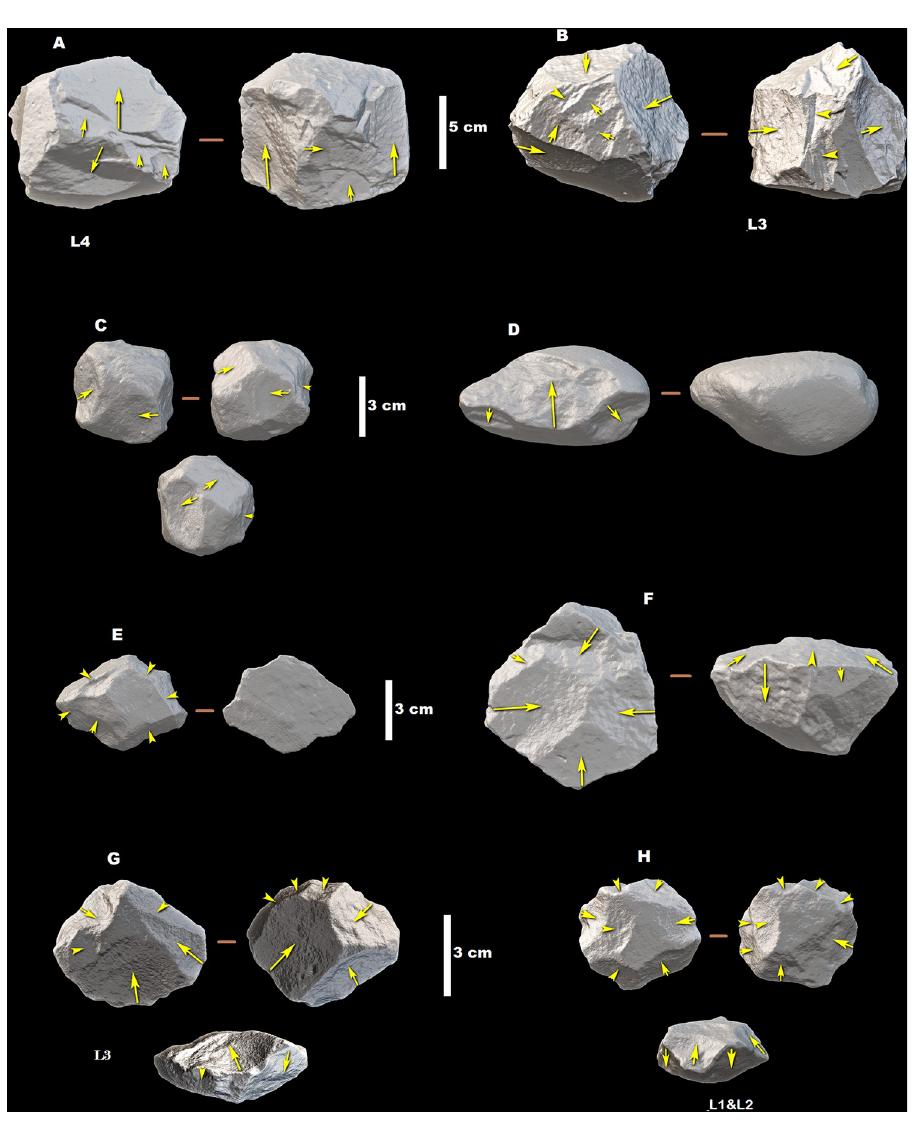
Fig 6. Cores from the small to medium-sized flaking system from MW2-L4 (A), MW2-L3 (B–G), and MW2-L1&L2 (H); (A), (B), and (C) are Multifacial cores; (D) Bifacial abrupt partial (BAP) exploited core; (E) Core on flake; (F) Bifacial hierarchical centripetal (BHC) exploited core; (G) and (H) are Discoids. (A), (B), (E), (G), and (H) are made on glassy ignimbrite, (C) and (F) are made on ignimbrite, and (D) is made on basalt. The arrows indicate direction of